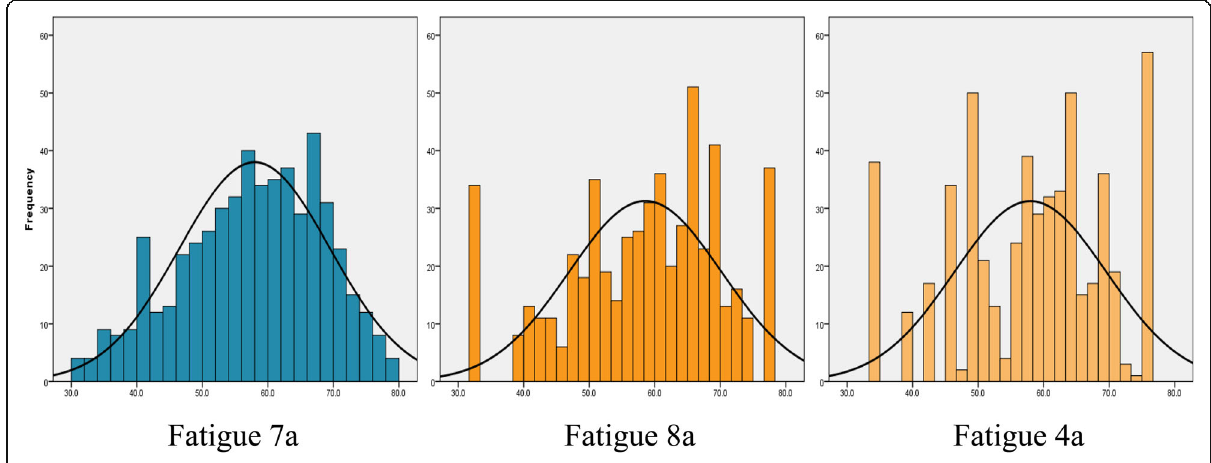
Fig. 1 Distribution of PROMIS Fatigue 7a, 8a, and 4a scores